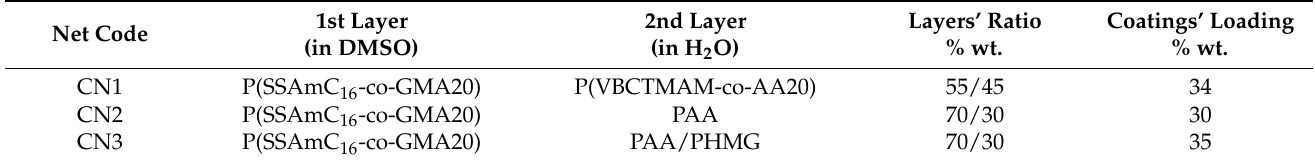
Figure 3. Multilayer coating of aquaculture nets with antimicrobial cationic polymeric materials. Table 2. Coated nets with P(SSAmC 16 -co-GMA20)/P(VBCTMAM-co-AA20), P(SSAmC 16 -co-GMA20)/PAA or P(SSAmC 16 -co-GMA20)/PAA/PHMG